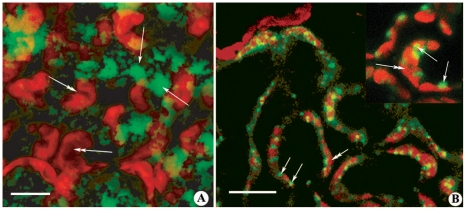
Subcellular localization of [Ca2+]cyt and H2O2 in G. biloba leaves upon herbivory.
A. False color images from confocal laser scanning microscopy shows that upon herbivory [Ca2+]cyt was found mainly in the cytosol, indicated by the calcium orange dye as green patches not associated with any specific organelle. Metric bar = 10 µm. B. H2O2 localization by Amplex Red shows a clear associations with microbodies (probably peroxisomes) and/or mitochondria but not with chloroplasts. Metric bar = 20 µm. In both panels, single arrows indicate the dye, double arrows indicate chloroplasts.